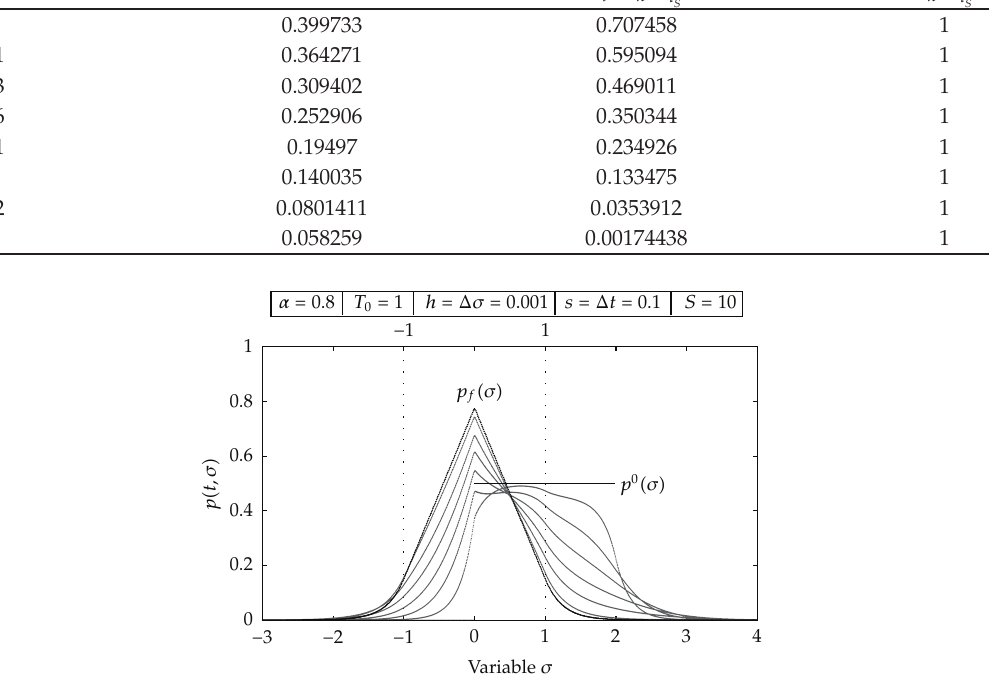
Figure 4: Graphics sequence: Subcase